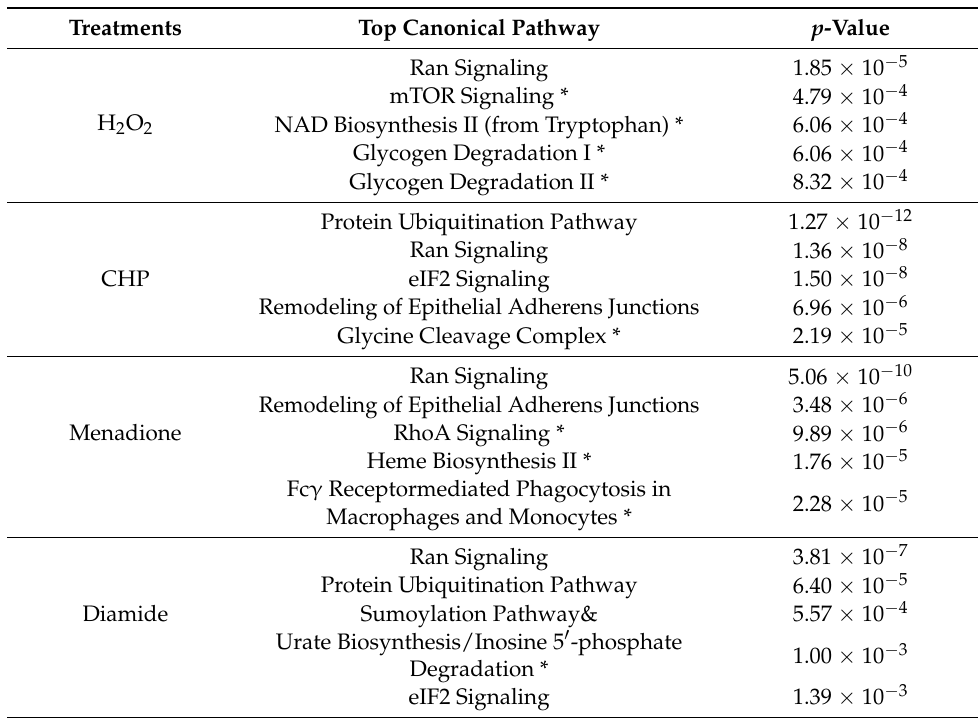
Table 2. Top five significant canonical pathways generated by IPA ® using significantly regulated proteins identified by label-free quantitative proteomics performed in S. cerevisiae treated with the four different chosen oxidants. Asterisks (*) indicate unique molecular and cellular function.